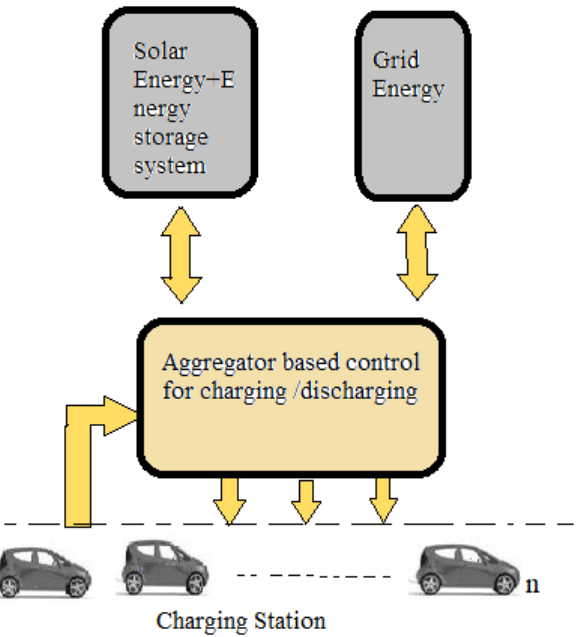
Figure 1. Aggregator ‐ based electric vehicle charging station with an integrated renewable energy source.